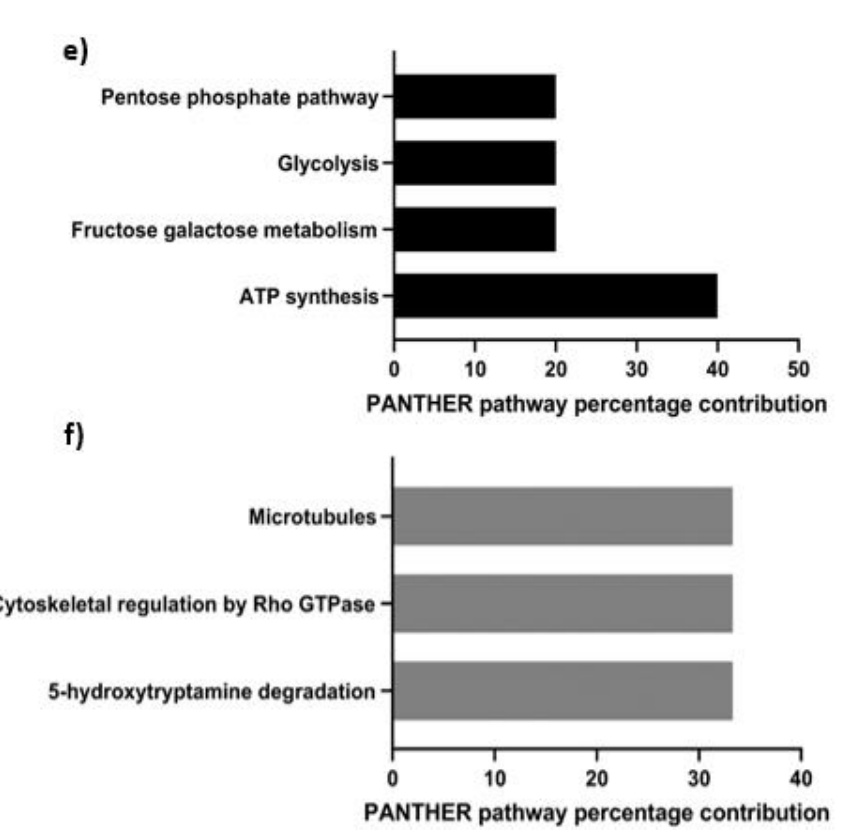
Figure 1. Percentage contributions of molecular function ( a , b ), biological process ( c , d ), and PANTHER ontological classification ( e , f ) pertaining to constituent interactome proteins associated with tACE in fresh and capacitated ( a , c , e ) or exclusively in capacitated ( b , d , f ) bovine sperm.